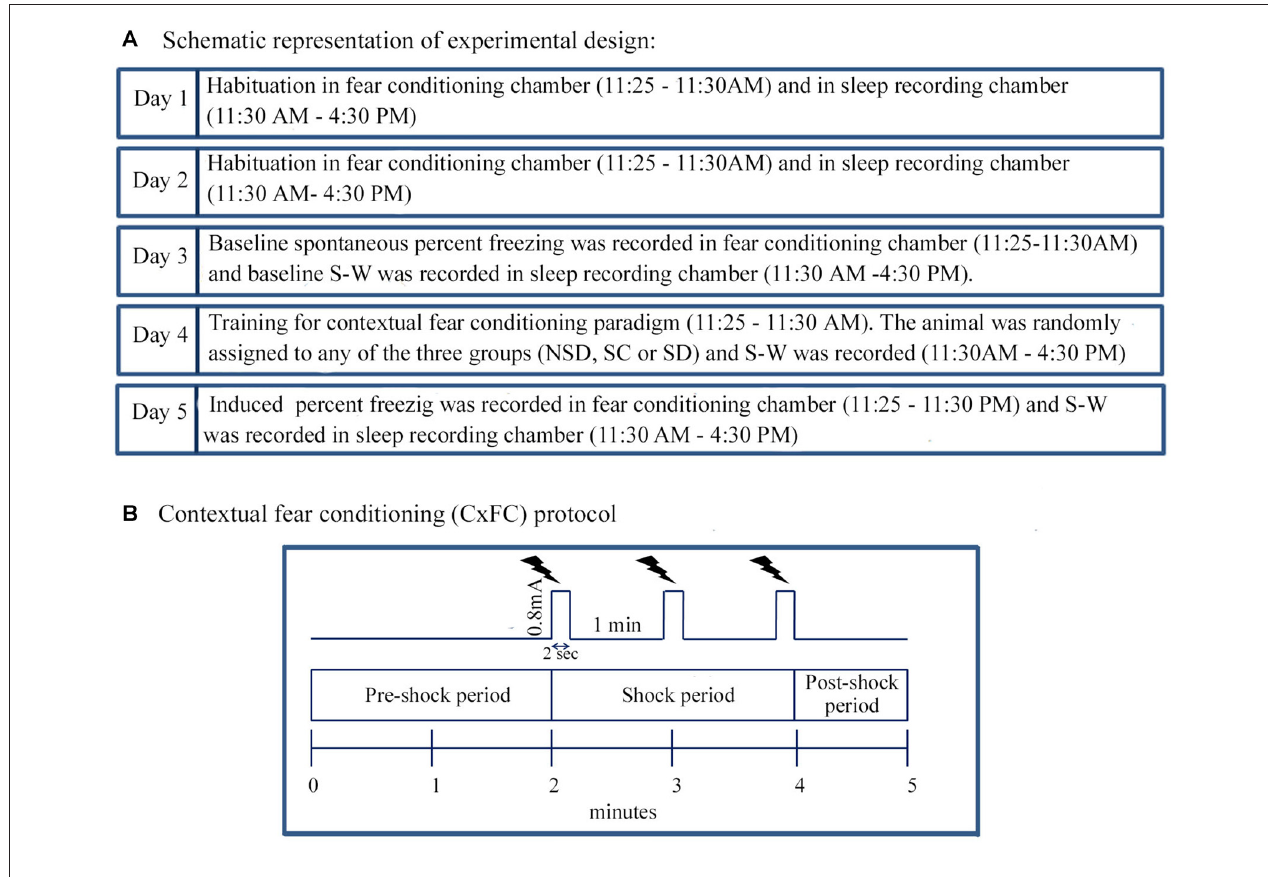
FIGURE 1 | The experimental design and Contextual fear conditioning protocol. (A) The animal was habituated in the fear-conditioning chamber between 11:25 AM and 11:30 AM and afterwards in the sleep recording chamber between 11:30 AM and 4:30 PM for 2 days (Day 1 and 2). The animal was also tethered to the sleep recording setup during habituation. On Day 3, the animal was placed in the fear-conditioning chamber, and spontaneous freezing was recorded between 11:25 AM and 11:30 AM. After that, baseline sleep-wakefulness (S-W) was recorded in the sleep recording chamber between 11:30 AM and 4:30 PM. On Day 4, the animal was trained for contextual fear conditioning using standard protocol during the time matched hour of the baseline day. The animal was then randomly assigned to either of the three groups: (a) non-sleep deprived (NSD); (b) stress control (SC); and (c) sleep-deprived (SD) group. S-W was recorded between 11:30 AM and 4:30 PM soon after contextual fear conditioning. On the subsequent day (Day 5), the animal was tested for contextual fear conditioning, and sleep was recorded during time-matched hour of baseline and training days. (B) The animal was kept in the conditioning chamber and was allowed to explore the chamber for initial 2 min (pre-shock period). After that, three-foot shocks (current strength: 0.8 mA, duration: 2 s inter-shock interval: 1 min) as an unconditioned stimulus was presented over 2 min period (shock-period). The animal was removed from the conditioning chamber 1 min after the last shock (post-shock